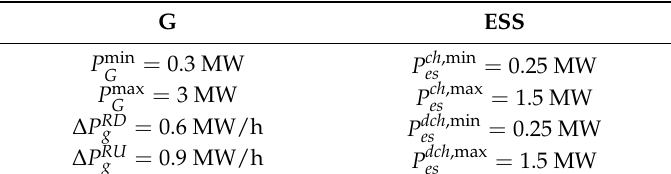
Table 2. Main parameters of the controllable sources in case.